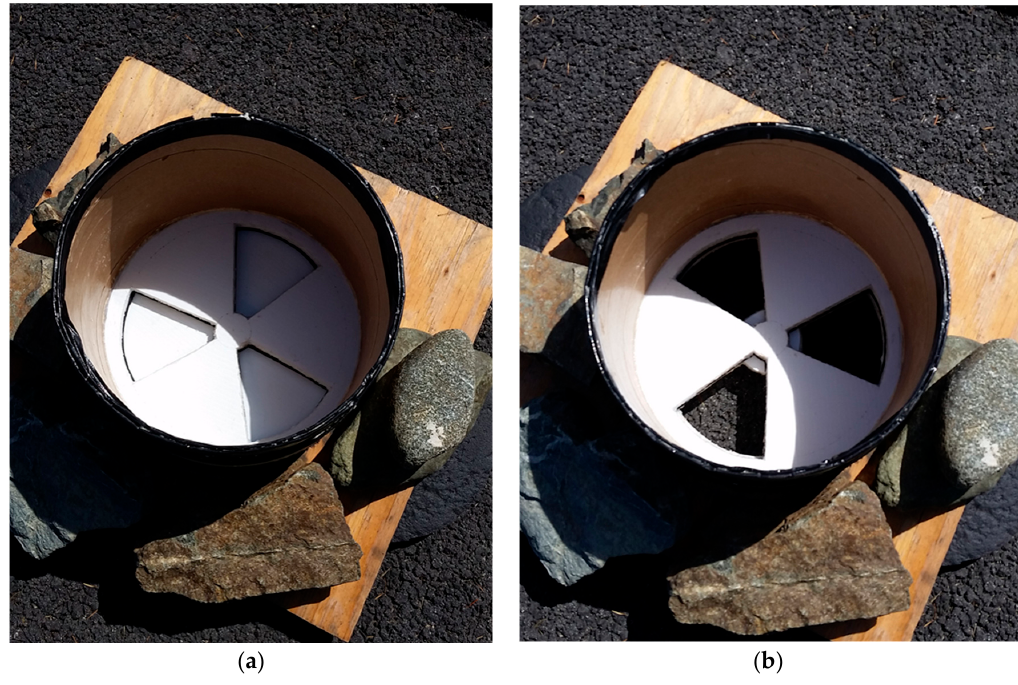
Figure 2. The falling head test device developed for comparison to the ASTM test when ( a ) closed and ( b ) open.